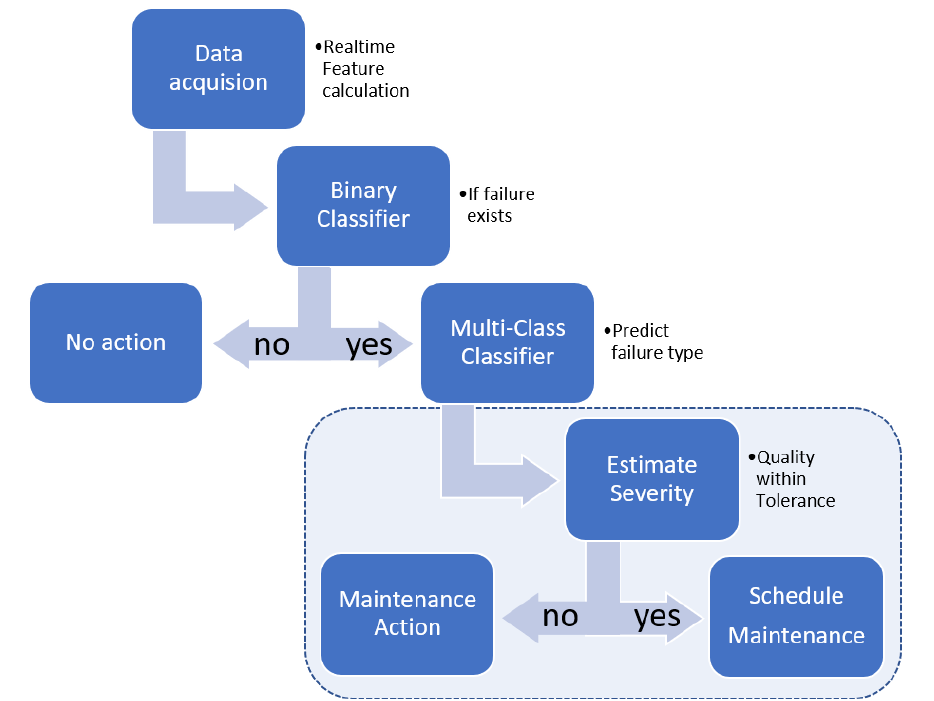
Figure 3. Failure prediction framework utilizing classification models for failure diagnostics and regression models as severity estimation for the prediction of produced quality. The bounding box represents the scope of this article.